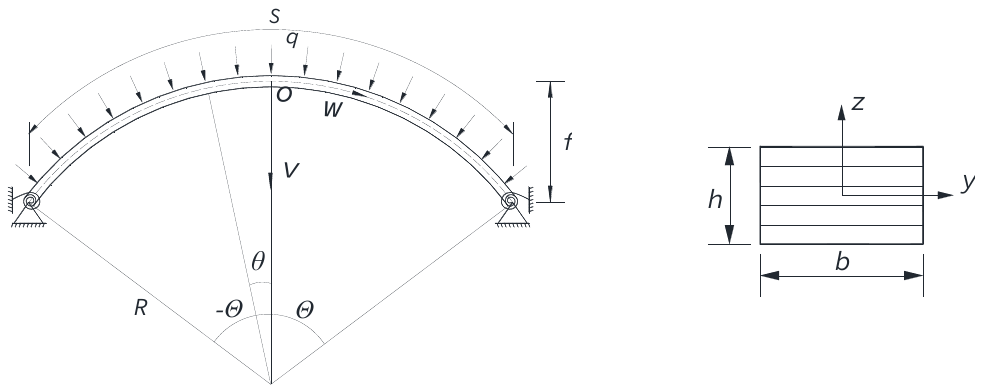
Figure 1. Configuration and coordinate system of the functionally graded graphene platelet-reinforced composite (FG-GPLRC) shallow arch with elastic rotational constraints.